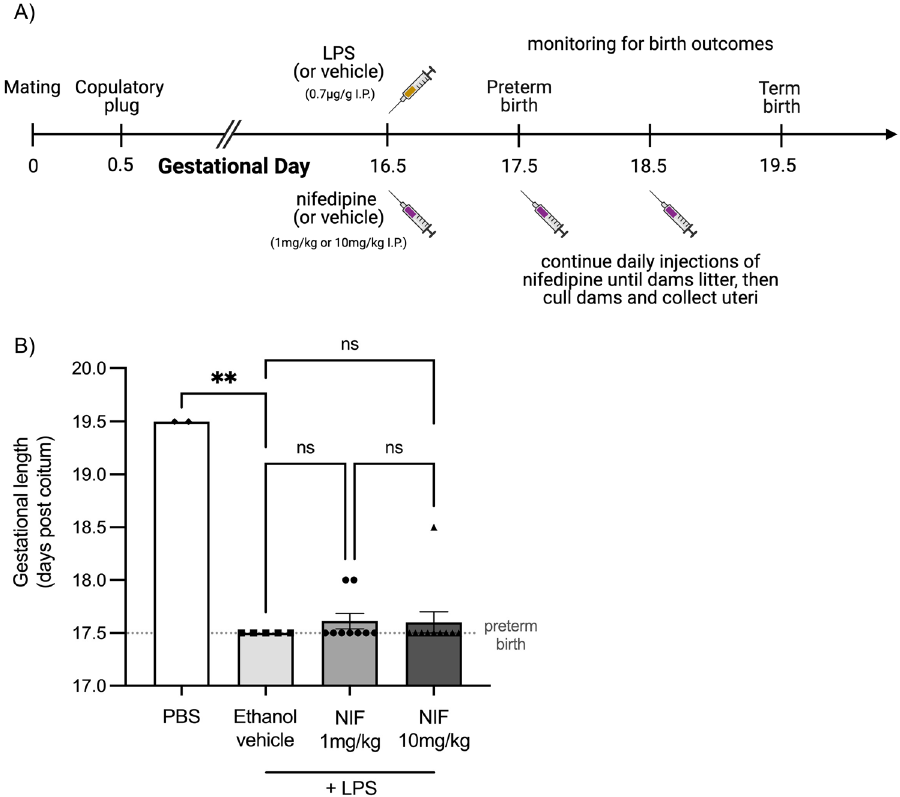
Figure 7. Mice treated with nifedipine (NIF) delayed LPS-induced preterm birth in some mice but was not consistent. ( A ) Timeline indicating the treatment time-points. Pregnant mice were injected intraperitoneal with lipopolysaccharide (LPS; n = 24) or vehicle (phosphate-buffered saline; PBS; n = 2) on gestational day (D)16.5. Mice were then immediately administered either vehicle (ethanol; n = 5), 1 mg/kg nifedipine (n = 9) or 10 mg/ kg nifedipine ( n = 10). Treatments were repeated every 24-h until birth. ( B ) Gestational length was calculated as days post coitum. Each data point represents one dam and error bars represent SEM, ns denotes no significant statistical difference between groups, and ** denotes P <